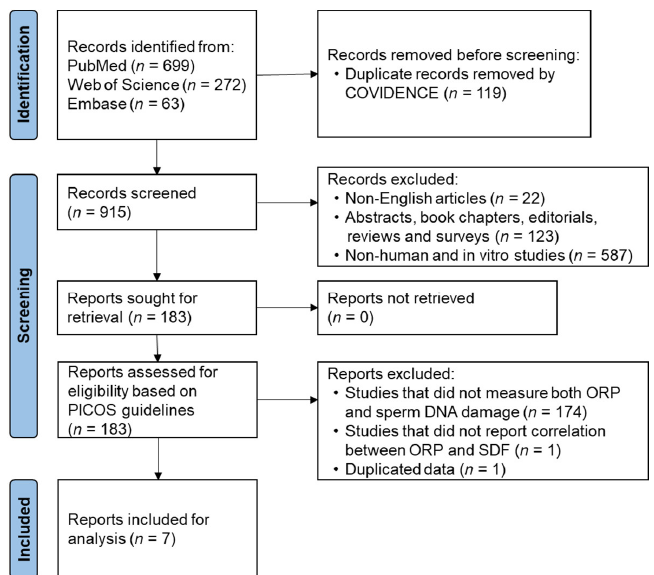
Figure 1. Flowchart of study identification and selection. ORP: oxidation-reduction potential, PICOS: population, intervention, comparison, outcome, and study design, SDF: sperm DNA